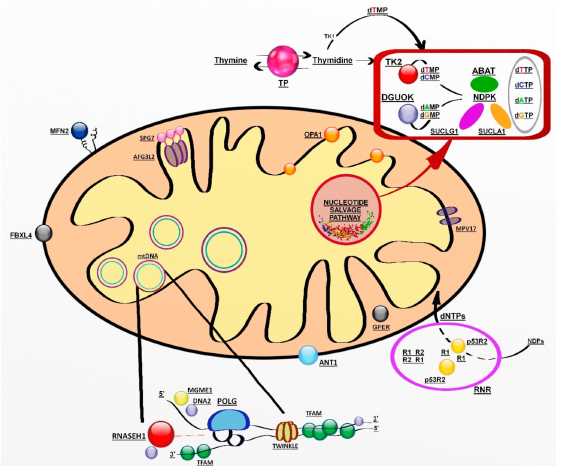
Figure 1. Genes involved in mitochondrial DNA